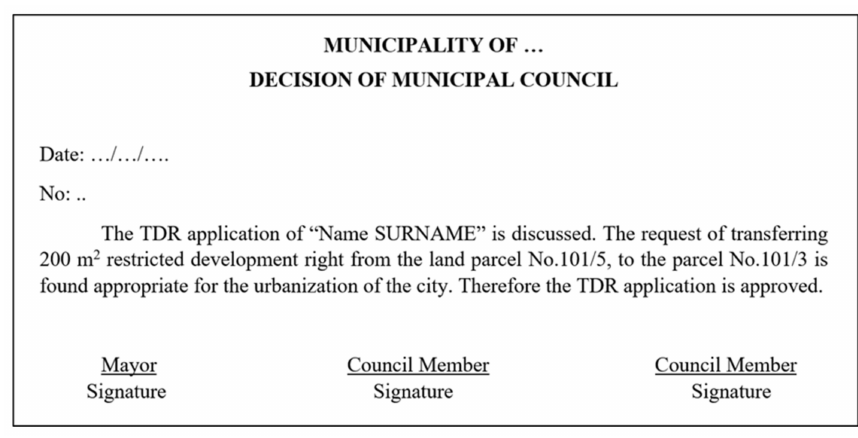
Figure 12. Decision of municipal council for TDR request.